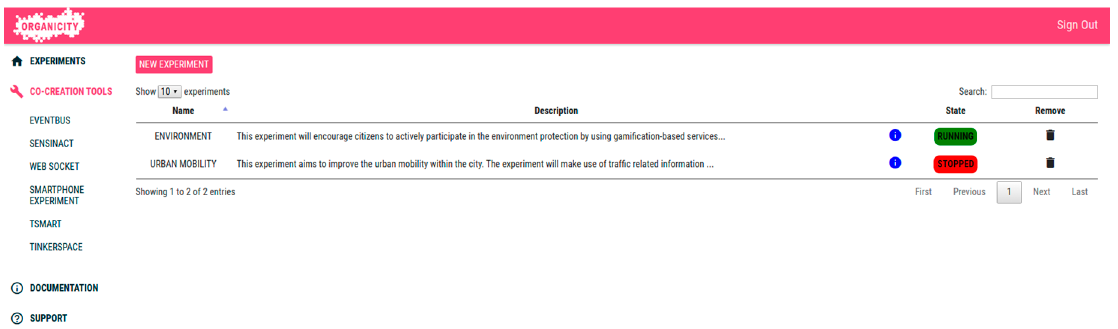
Figure 10. Experiment list within the main view of the EP.